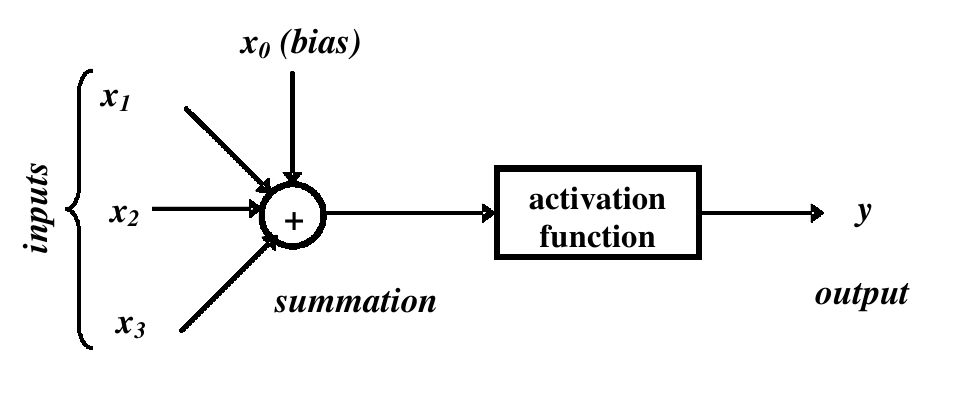
Fig. 1 A unit of a multi-layer